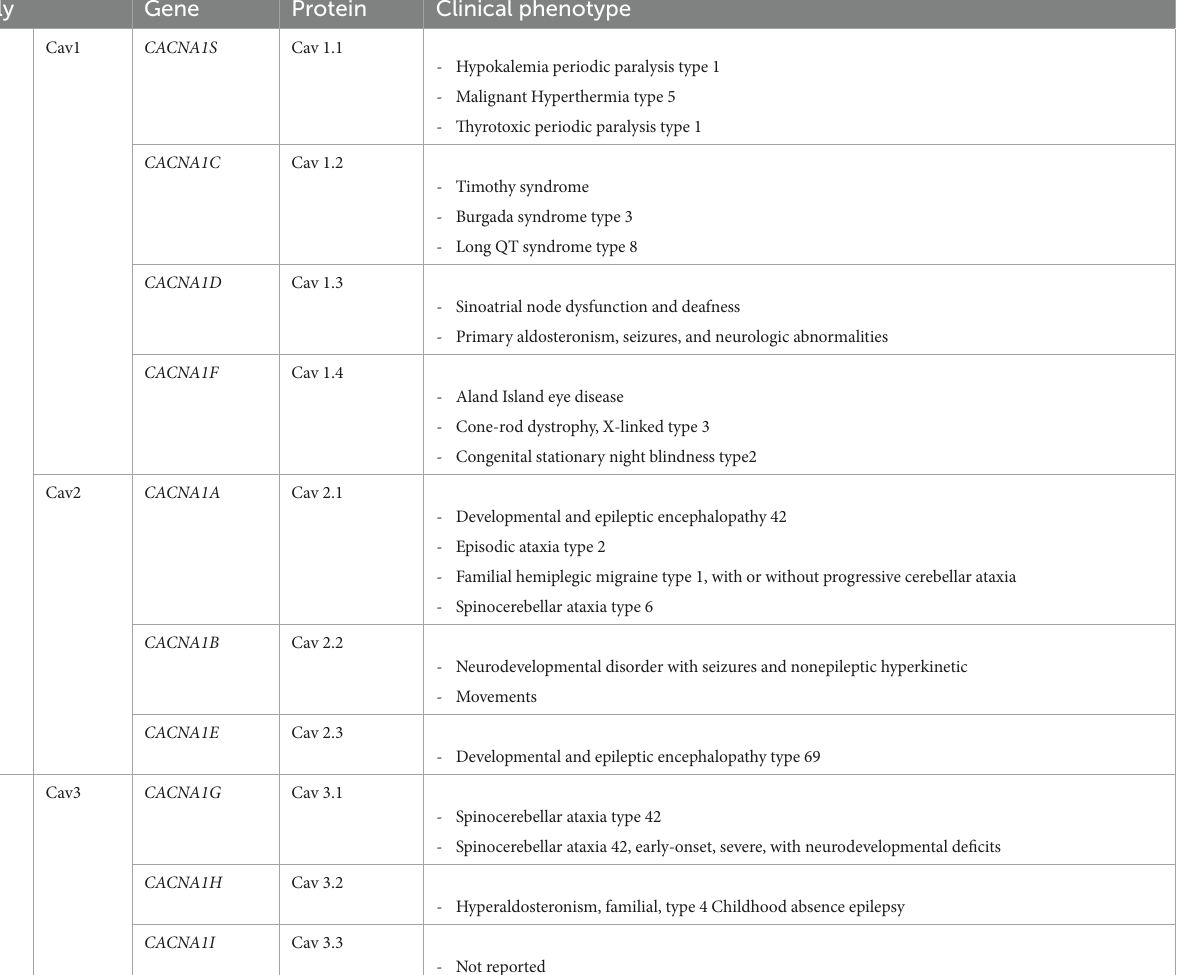
TABLE 1 Voltage-gated Ca 2+ channels: classification and human genetic disease. *